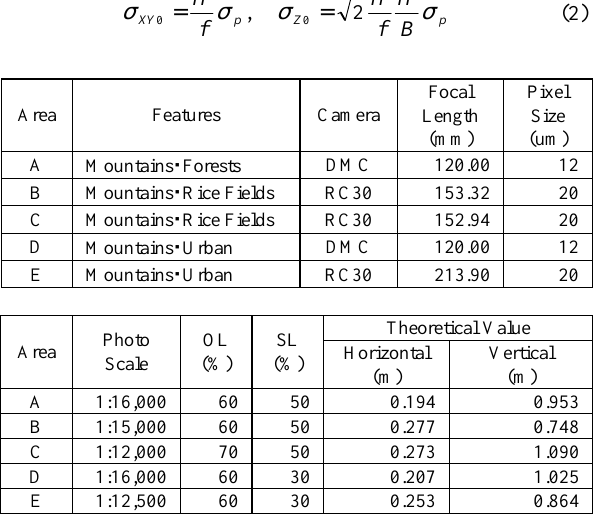
A quantitative evaluation of the RPM is performed by calculating the elevation gap between the matched DEM and the airborne lidar data treated as the most probable value. The elevation gaps are calculated at the check points where the edges of the features on the digital ortho photographs can be clearly distinguished. Here, points with elevation gaps over the theoretical value for the vertical direction, as shown in Table 1, are regarded as mismatched points.The airborne lidar data satisfies the accuracy of map level 2500, with a density of 2.8 points per square meter.